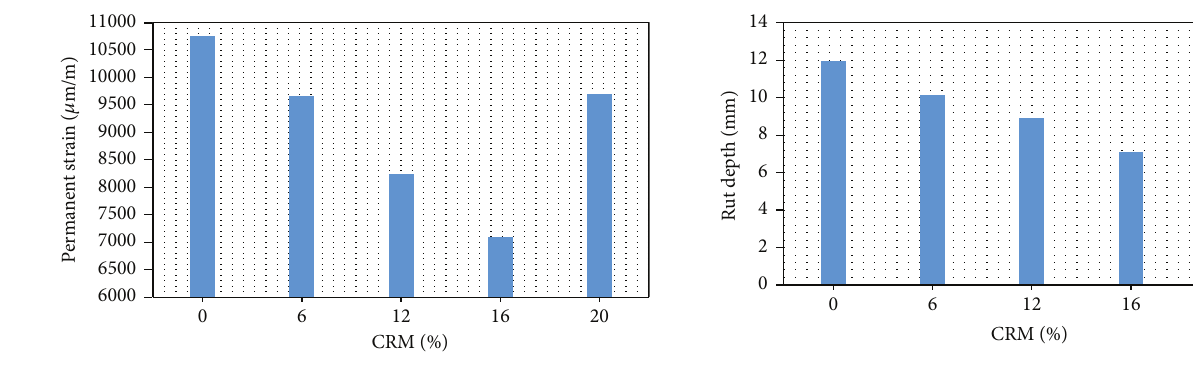
Figure 3: Permanent strain (dynamic creep) versus CRM content. Figure 4: Rut depth versus CRM